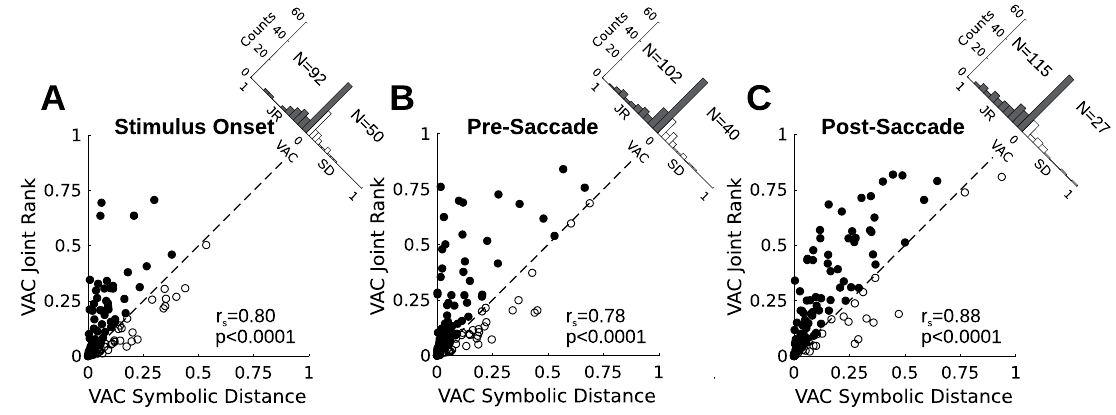
Figure 5. Variance accounted for (VAC) by Joint rank vs. symbolic distance. N = 142 recordings. ( A ) VAC in firing rate activity aligned to stimulus onset, r s is Spearman’s rank correlation, p is the probability associated with r s . Filled symbols have JR > SD, open symbols have SD > JR. Inset histogram shows distribution of SD-JR. N is total number of recordings in each group. ( B ) VAC in activity prior to saccade onset. Same format at ( A ). ( C ) VAC in activity prior to saccade onset. Same format as ( A ).